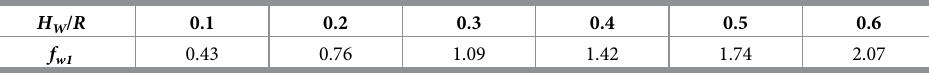
Table 12. Coefficient of impulsive hydrodynamic pressure f w 1 for a ground-level circular tank. H W /